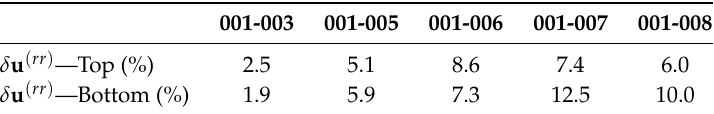
Figure 10. Example of detected the bottom and top positions of the pedestrians of Camera Network 6—PETS2009-S2L1 dataset. Red color represents detected positions by the human pose estimation method. Green color represents the detected reprojected positions. Table 10. Calibration results of camera calibration based on multiple walking people of the Camera Network 6. δ u ( rr ) denotes the relative reprojection